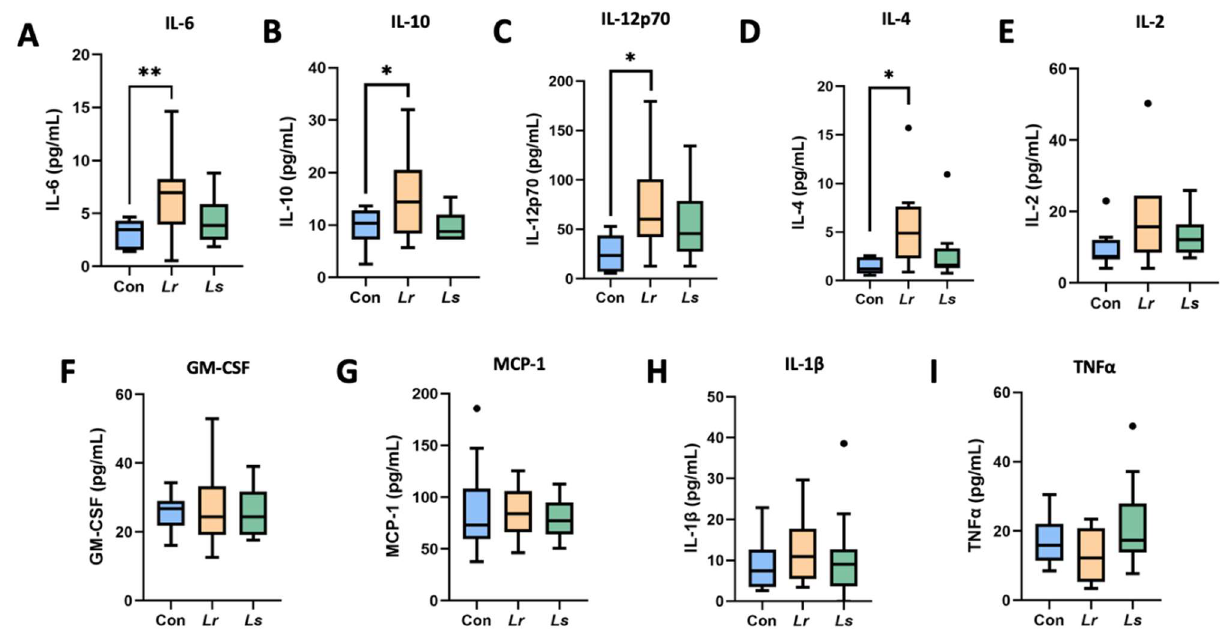
Figure 4. Panel of serum cytokine levels following probiotic treatment. Detected concentrations of IL-6 ( A ), IL-10 ( B ), IL-12p70 ( C ), IL-4 ( D ), IL-2 ( E ), GM-CSF ( F ), MCP-1 ( G ), IL-1β ( H ), and TNFα ( I ) in serum between groups. N = 10–14 mice/group. Con—Control; Lr — L. rhamnosus HA-114; Ls — L. salivarius HA-118. The box extends from the 25th to 75th percentiles with the whiskers representing the furthest point that is within 1.5 times the IQR. * p < 0.05; ** p < 0.01.